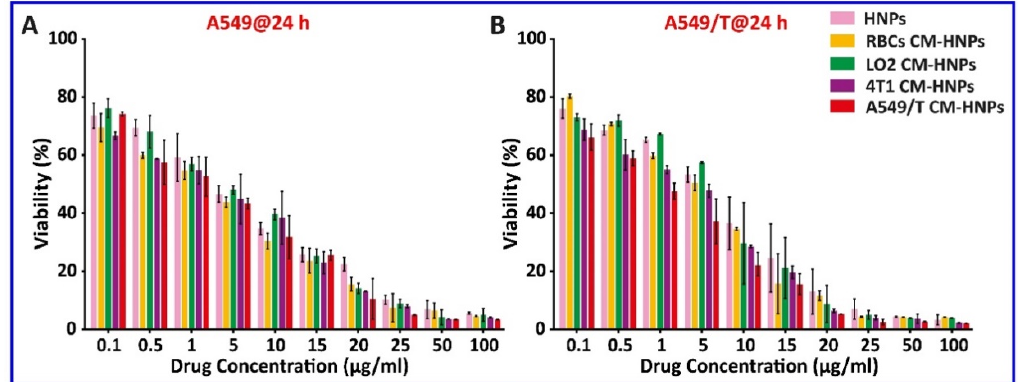
Figure 9. Cell viability. Viability of ( A ) A549 or ( B ) A549/T cells after treatment for 24 h at varied PTX concentrations ranging from 0.1 to 100 μ g/mL; n = 3.